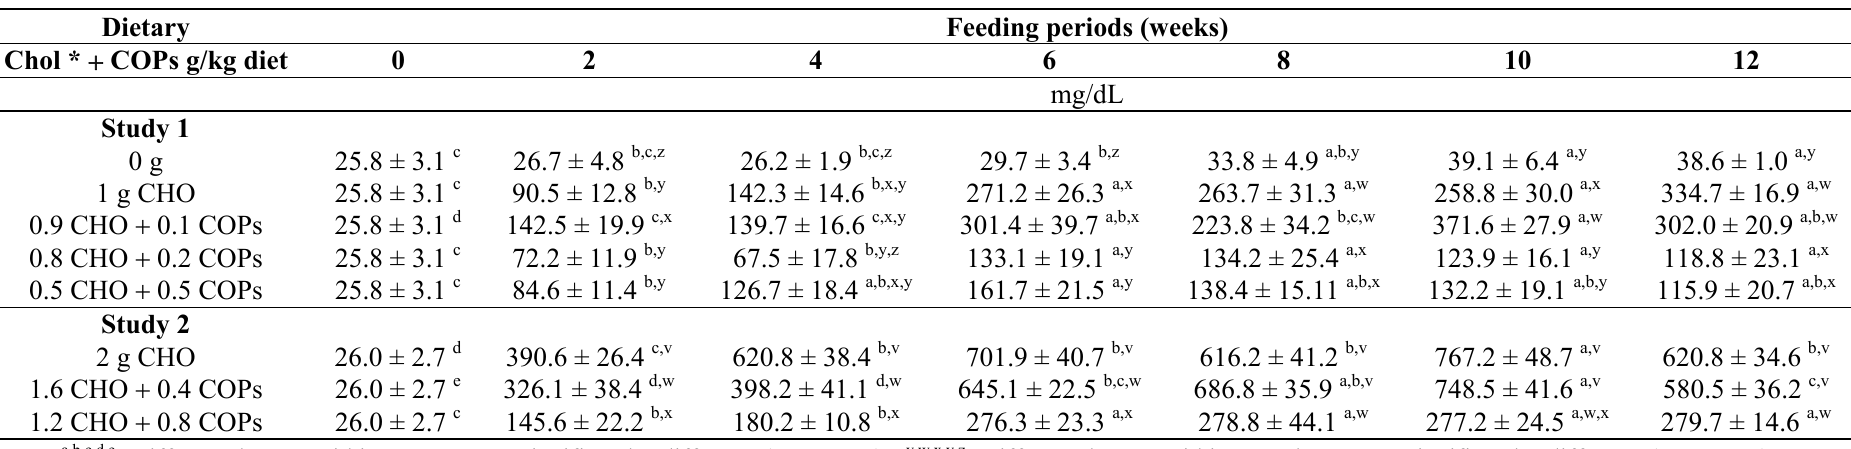
Table 2. Effect of dietary cholesterol and cholesterol oxides on total cholesterol content in serum. Dietary Feeding periods (weeks)